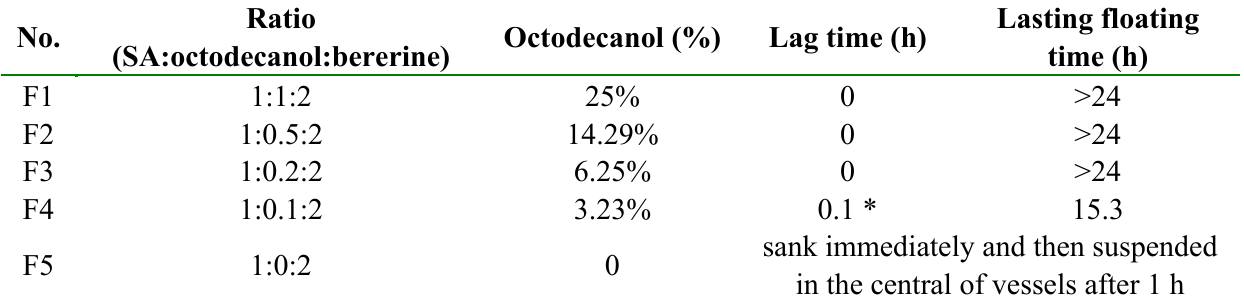
Table 2. Lag time and lasting floating time of different formulas (n = 6).